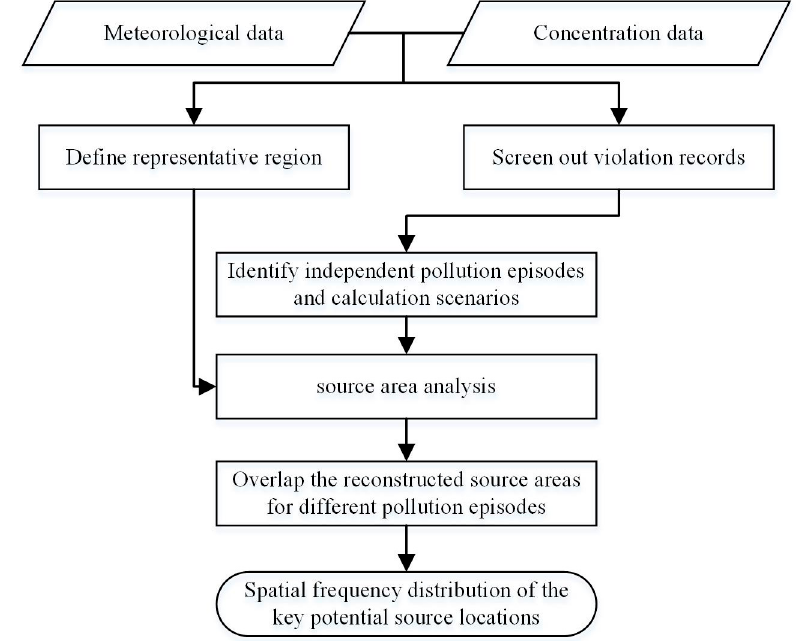
Figure 4. Flow diagram of the statistical source area analysis method.